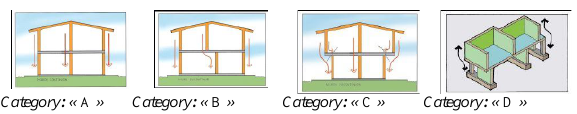
Fig. 2. Effect of the vertical regularity of the masonry construction: « A = Very safe », « B = Safe », « C = Dangerous » and « D = Very dangerous »